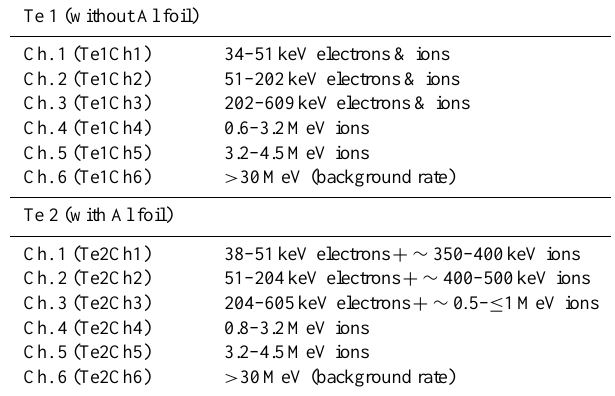
Table 1. Energy channels of two telescopes (Te1 and Te2) of the SLED instrument aboard the Phobos-2 spacecraft (McKenna- Lawlor et al., 1992). The abbreviations in parentheses are used later in this paper when referring to the energy